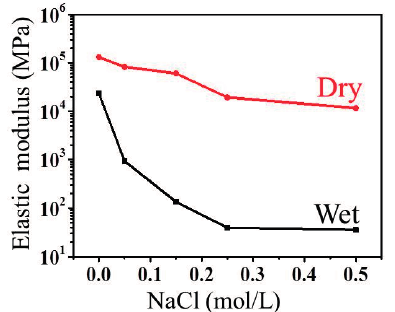
Figure 7. The properties of electrodeposited chitosan films are sensitive to the conditions used during the deposition process ( i.e. , the addition of salt to the deposition solution). The elastic modulus was measured by quartz crystal microbalance with dissipation.